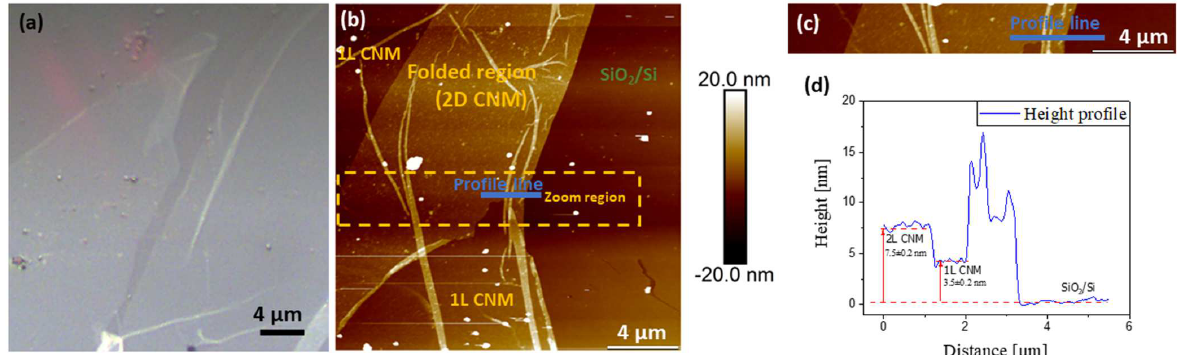
Figure 2. Representative AFM images of synthesized NBPS-CNMs. ( a ) Optical image, ( b ) AFM topography, ( c ) Magnified region, and ( d ) Height profile along the scan path defined in the magnified region. A folded bilayer CNM along the AFM scan path is defined by the height of the height line in blue color.